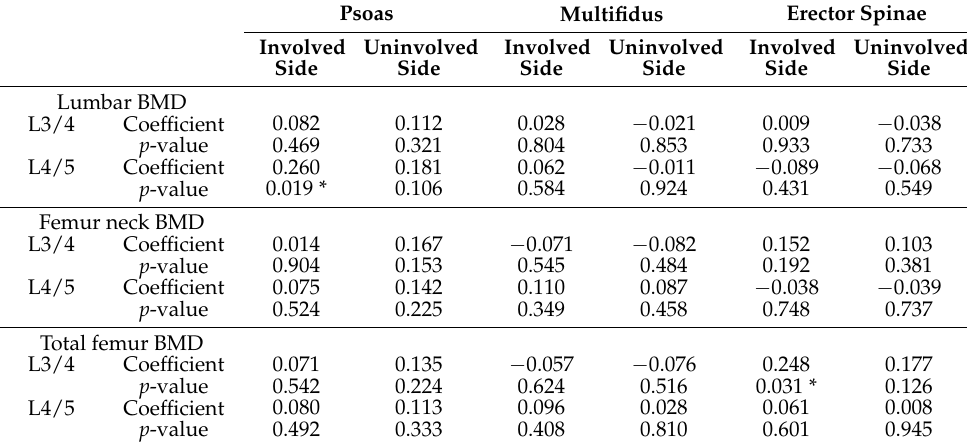
Table 2. Pearson correlation analysis to analyze the correlation between the CSA of lumbar spinal muscles and lumbar BMD.